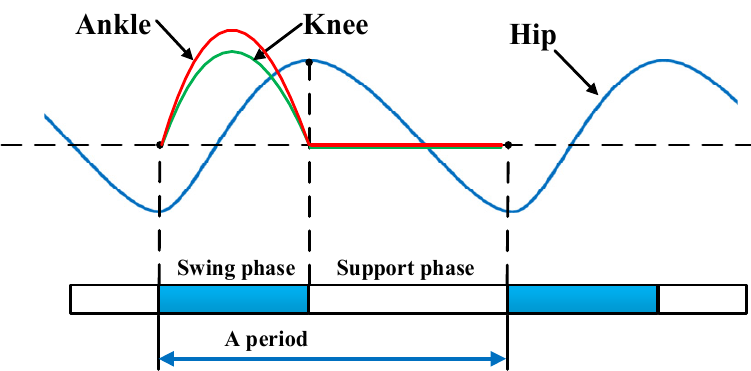
Figure 6. The gait planning of the hexapod robot.